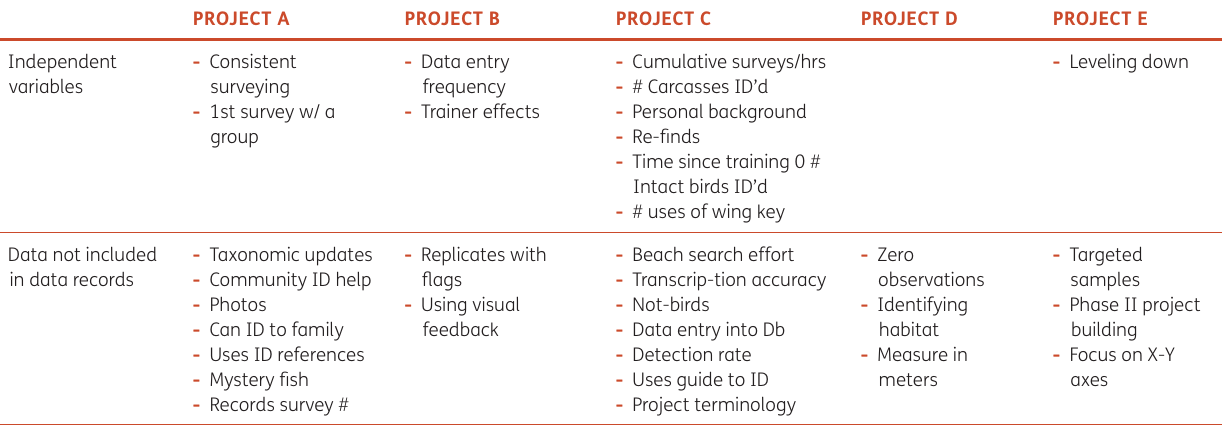
Table 6 Skills that were independent variables or unavailable in data